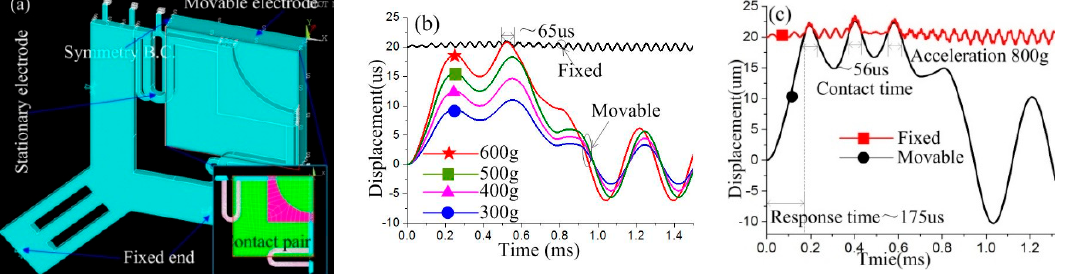
Figure 7. ( a ) The one quarter finite element model of designed inertial micro-switch. ( b ) The dynamic response curves of proof-mass and contact point under different acceleration loads. ( c ) The dynamic response curves of proof-mass and stationary electrode spring under an overload acceleration of 800 g.